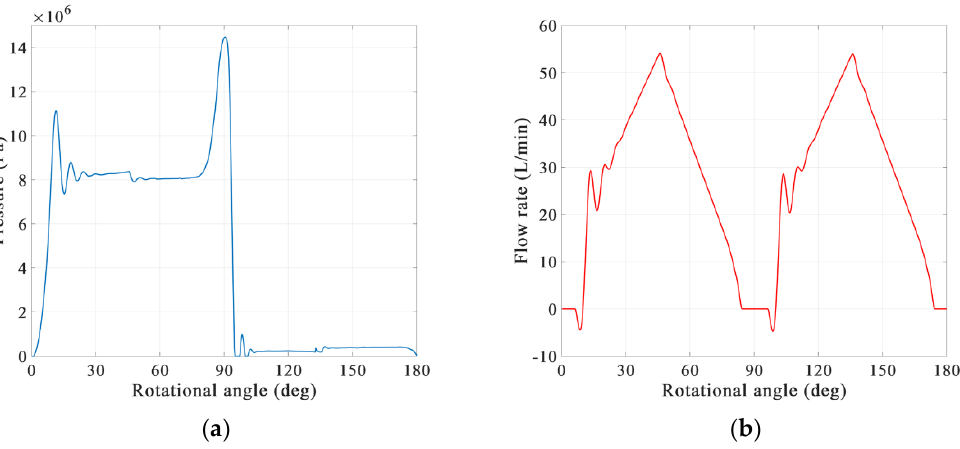
Figure 14. ( a ) The pressure in the left chamber and ( b ) the outlet flow of the pump unit. In order to study the outlet load of the pump unit in the parallel 2D piston pump, the pressure distributions of the outlet flow zone are plotted as shown in Figure 15. In the parallel 2D piston pump, the symmetrical distribution of the left and right pump units can cause the oil to move left and right, so that the outlet load fluctuation of the pump unit can have an effect on the pressure fluctuation and pressure decline in the chamber. The influence of the symmetrical distribution of the left and right pump units on chamber pressure will continue to be a concern.